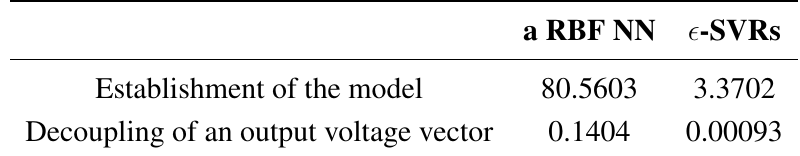
Table 4. Mean elapsed time (in seconds) of the training process and the testing